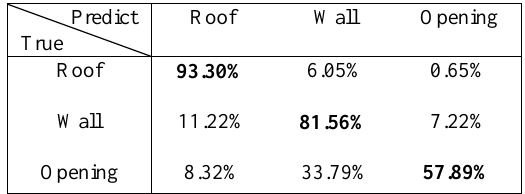
Table 3 Pixelwise accuracy of random forest using both 2D and 3D features.